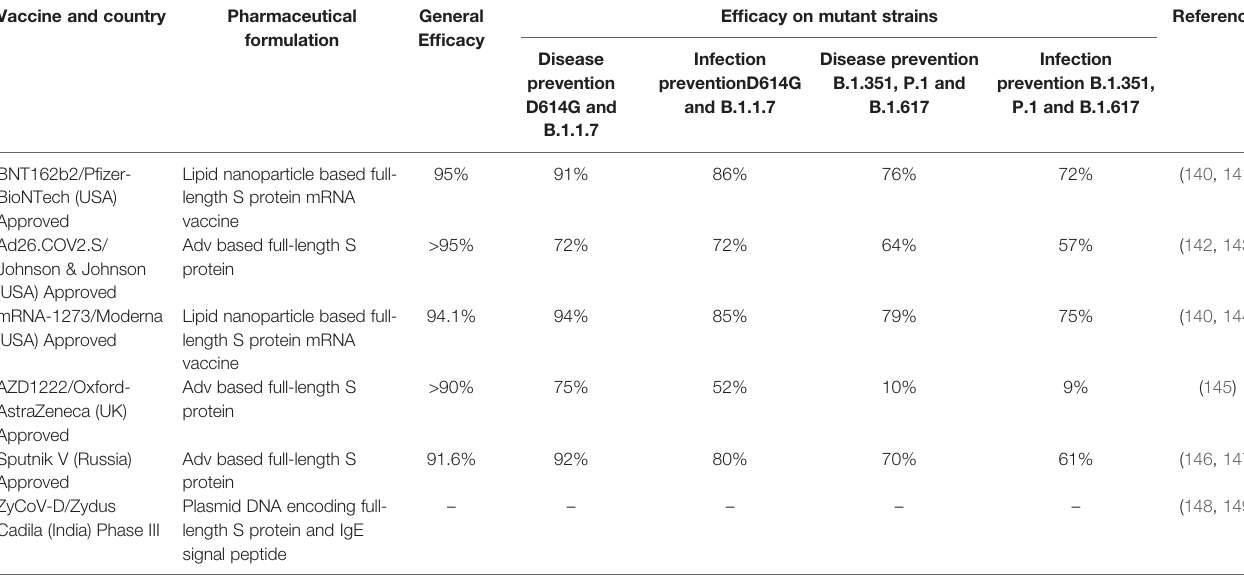
TABLE 4 | Currently approved Spike protein (S) -based important COVID-19 vaccines and their ef fi cacy on Spike mutant strains. Vaccine and